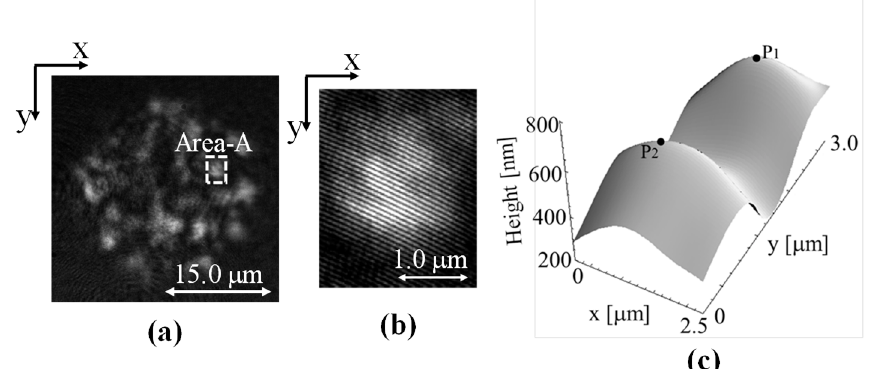
Figure 5. Speckle pattern and measured result: ( a ) Measurement area in the speckle interferogram; ( b ) Area-A; ( c ) Three-dimensional shape.